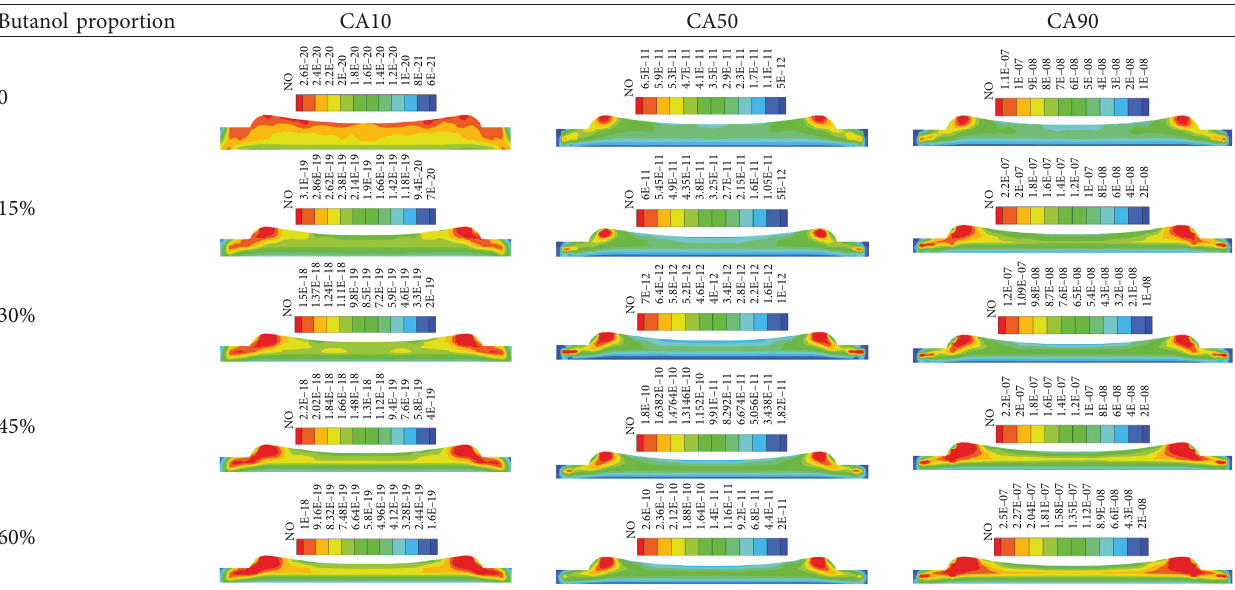
Table 3: The in-cylinder distribution of the nitric oxide